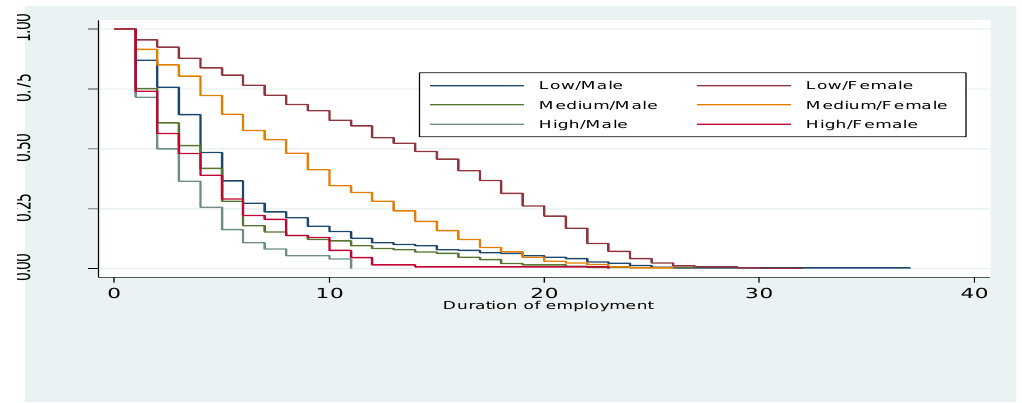
Figure 18: Survival function by gender and education